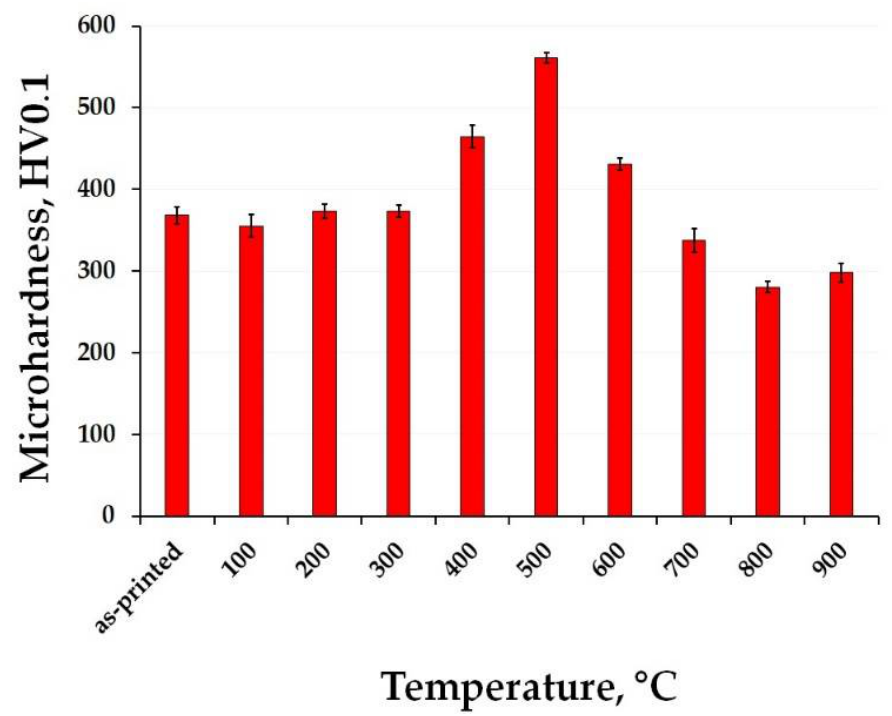
Figure 1. Microhardness of the as-printed 1.2709 maraging steel as a response to exposure to differ- ent temperatures with a total dwell time of 2 h. temperatures with a total dwell time of 2